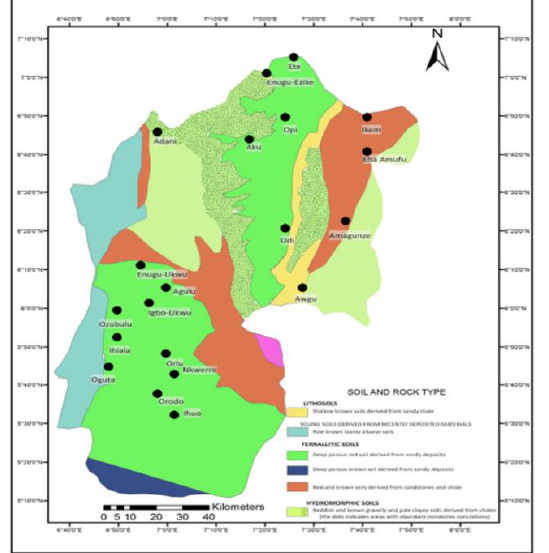
Figure 3: Spatial distribution of Soil and Rock Type across the Study Area.